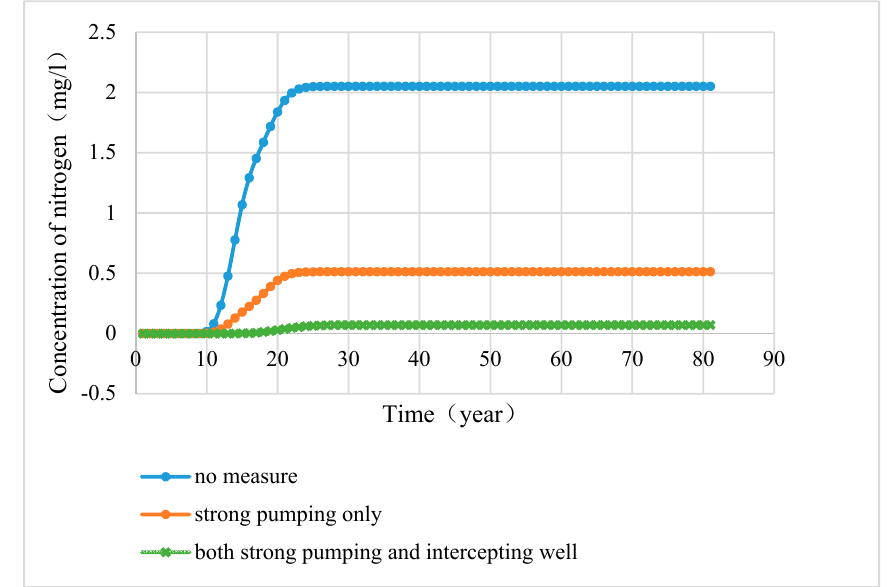
Figure 17. Comparison of ammonia nitrogen concentration changing curves in monitoring well JC2 under three working conditions.